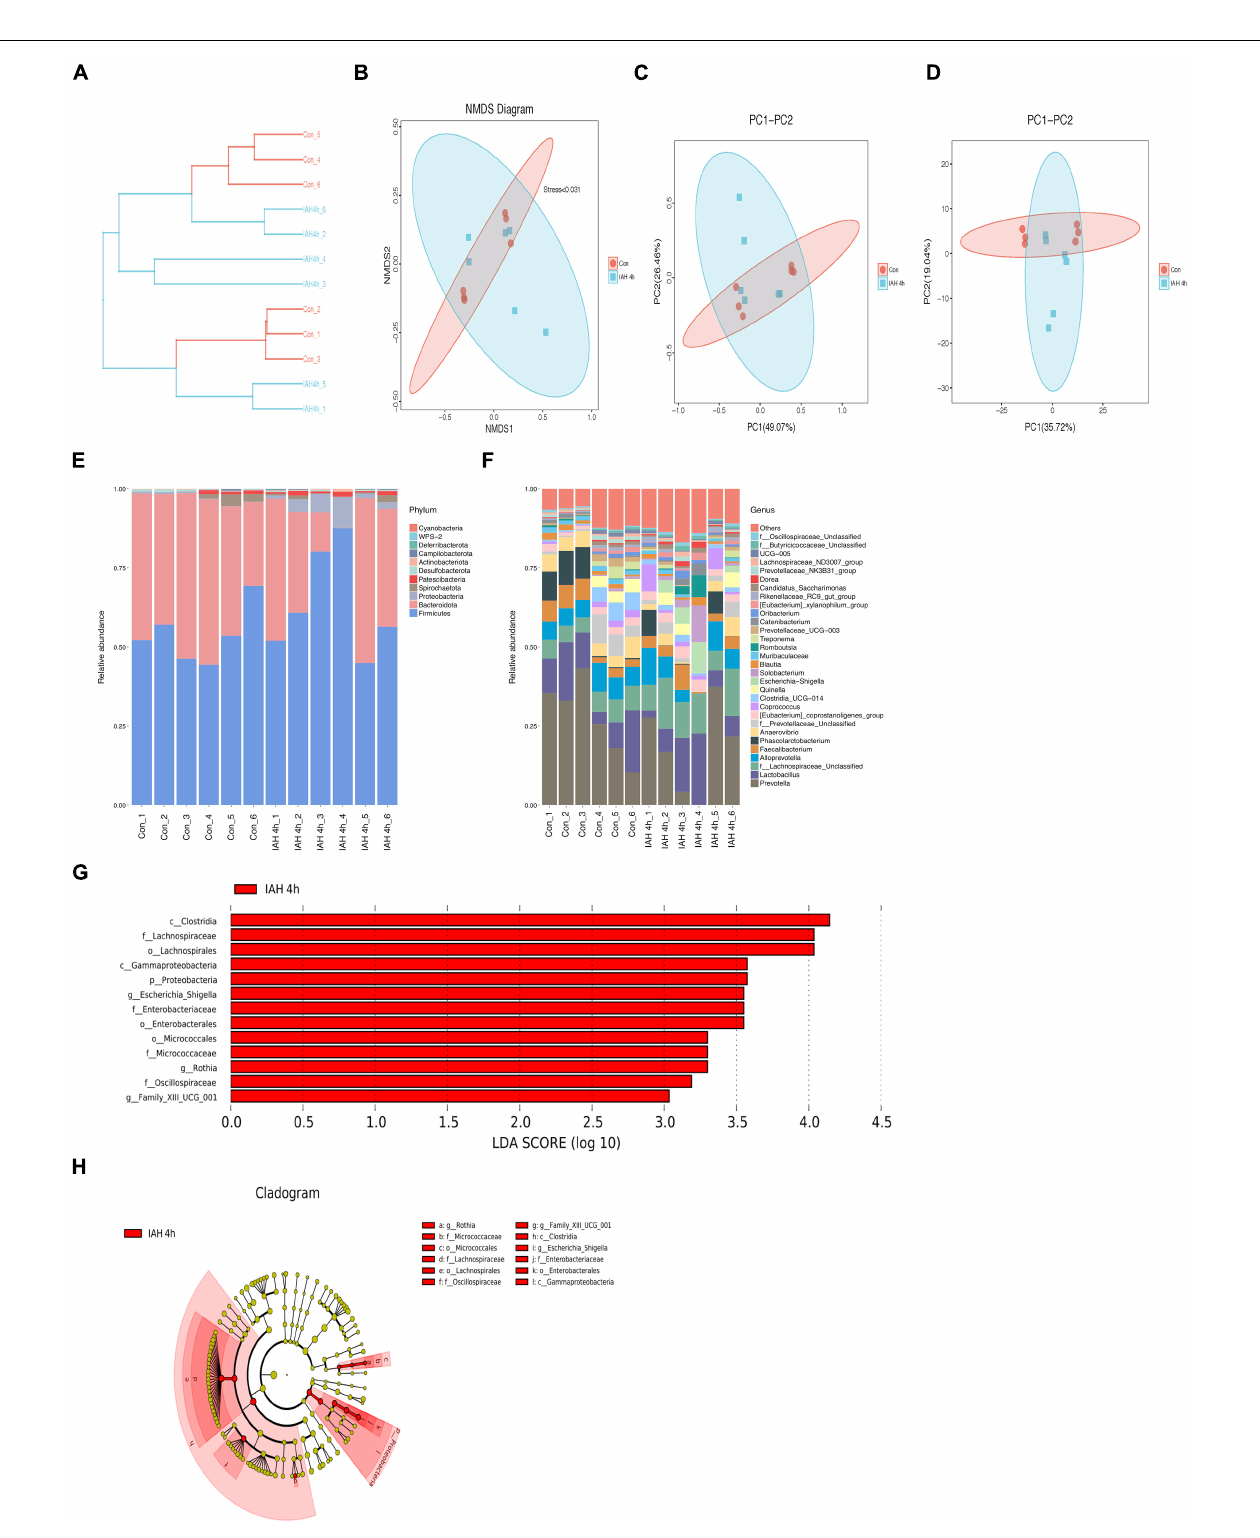
FIGURE 3 | (A) Different branches accumulated in the IAH 4 h group and control group were, respectively, presented in the UPGMA clustering tree. The composition of beta-diversity between the control group and the IAH 4-h group. Scatter plots of NMDS (B) , PCoA (Bray–Curtis matrix) (C) , and PCA (OTU abundances) (D) for gut microbiota. Each symbol represents one sample. The percentage of total microbiota between the control group and the IAH 4-h group was presented at phylum (E) and genus (F) levels. The enriched bacteria in the IAH 4-h group was presented by the LEfSe analysis (G,H) .